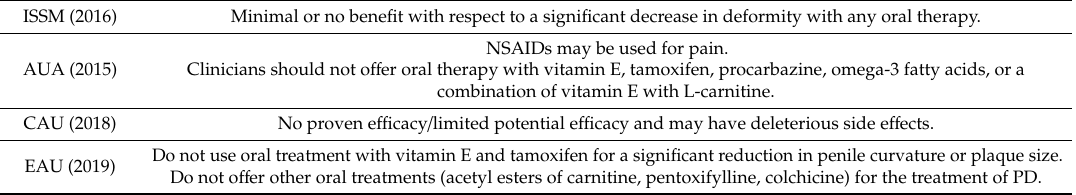
Table 5. Guidelines on Oral Therapy for Peyronie’s Disease.